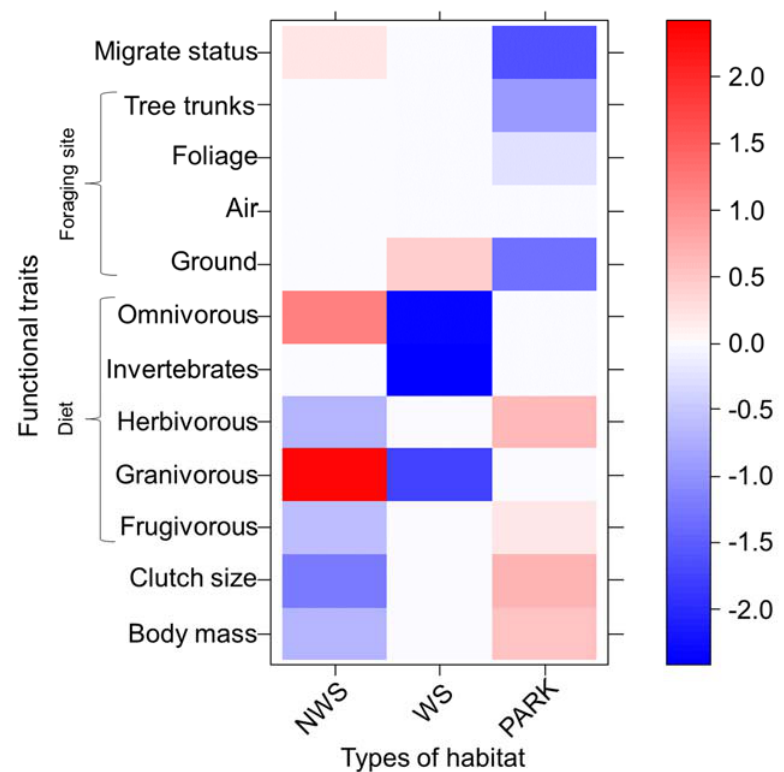
Figure 4. Fourth corner solution results. Functional traits were: body mass; clutch size; diet (frugivorous (fruit feeders), granivorous (seed feeders), herbivorous (plant material feeders), invertebrates (invertebrate feeders), and omnivorous (those that feed of more than three diet items)); foraging site (tree trunks, foliage, air, and ground). The scale bar indicates the interaction coefficients and the strength of the association between traits and habitats. Red = positive relation. Blue = negative relation. NWS = non-wooded streets, WS = wooded streets.